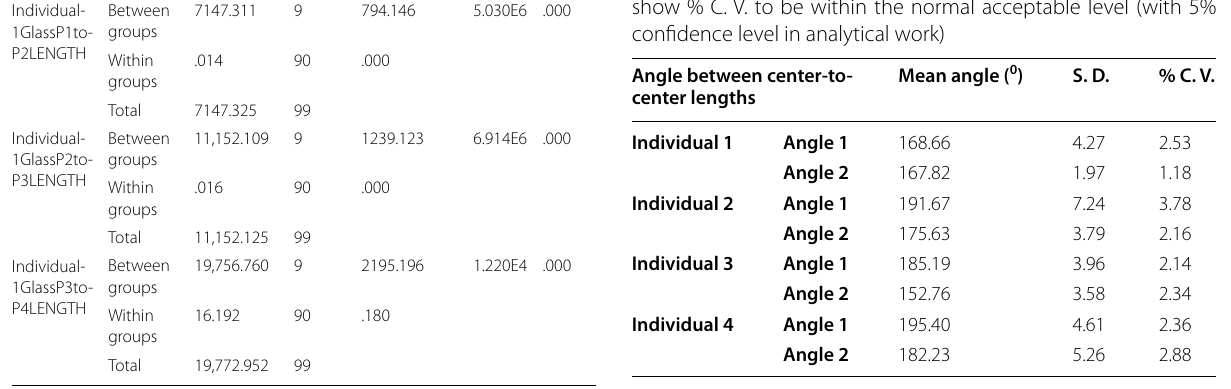
Table 10 Mean angle between center-to-center